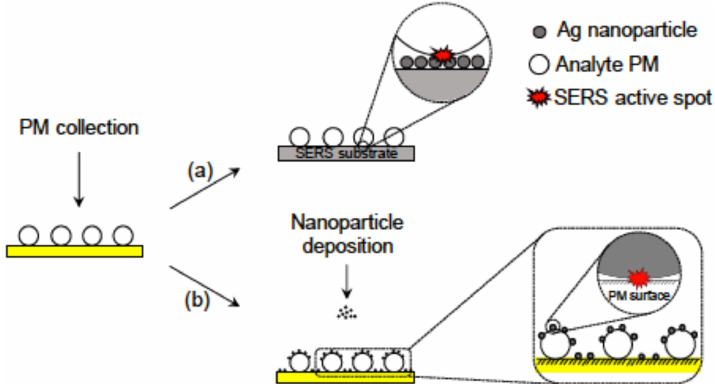
Figure 5. Schematic illustration of (a) a conventional SERS substrate approach and (b) the ES-SERS approach (Gen and Chan, 2017).